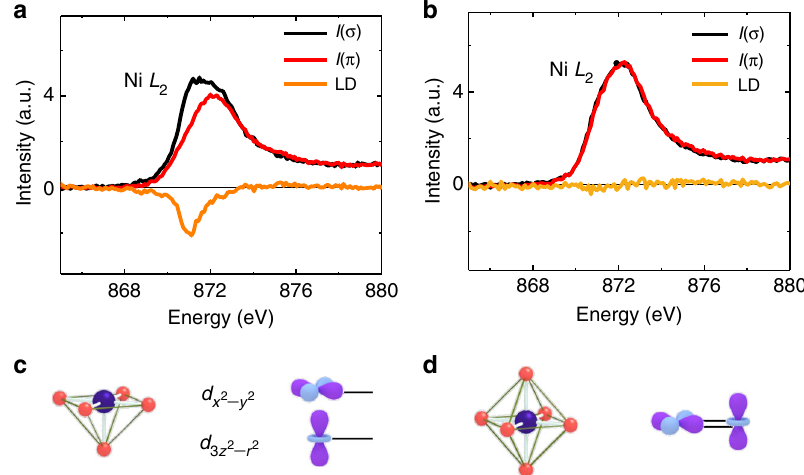
Fig. 3 Orbital polarization of the Ni-3 d orbital by oxygen coordination control. a Polarization dependent X-ray absorption spectroscopy (XAS) of Ni L 2 edge for a S 7 /L 1 and b S 3 /L 1 superlattices. Large linear dichroism (LD) is observed for the S 7 /L 1 SL, whereas the LD is nearly zero for the S 3 /L 1 SL. Schematics of the e g orbital con fi guration are shown for c S 7 /L 1 and d S 3 /L 1